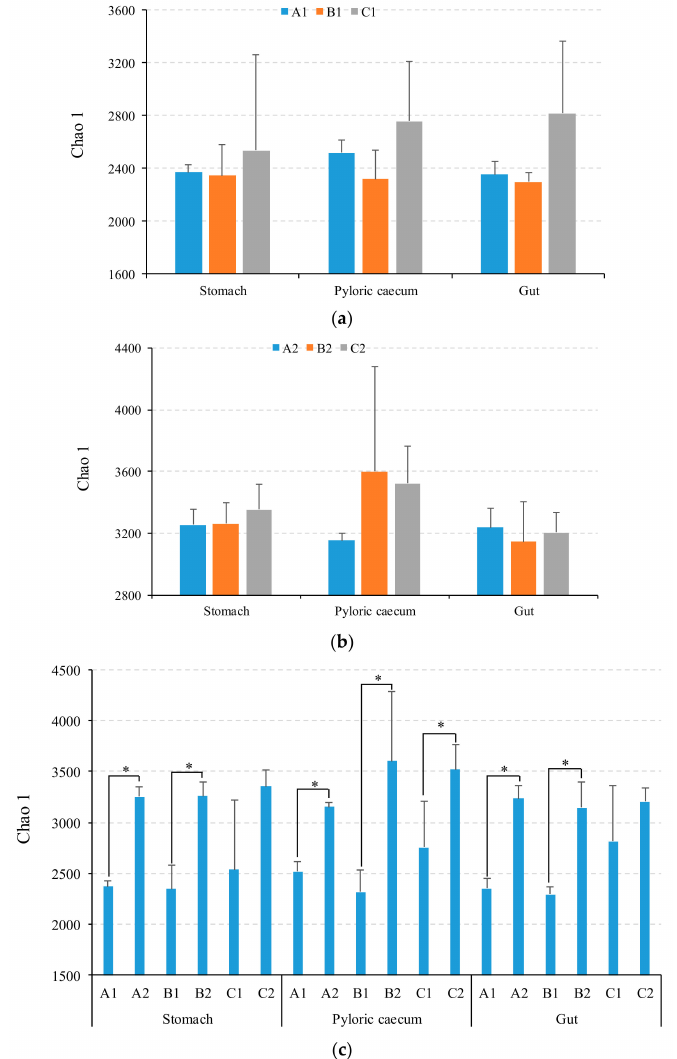
Figure 2. Chao1 indices of microbiota in yellowtail kingfish gastrointestinal tracts. Notes: ( a ) at the beginning of the study; ( b ) at the end of the study; ( c ) the analysis of the Chao1 indices of gastrointestinal microbiota between the beginning and end of the study. A1, B1, and C1 represent the low-, medium-, and high-density groups at the beginning of the study, while A2, B2, and C2 represent the low-, medium-, and high-density groups at the end of the study. * represents the significant differences in each density group between the beginning and end of the study ( p ≤